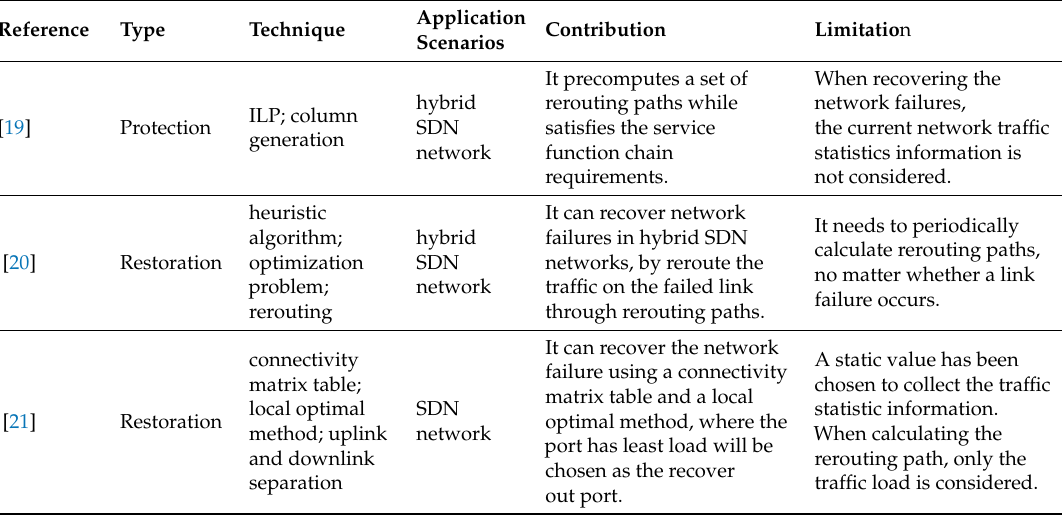
Table 1. Brief analysis of REVERT and the existing